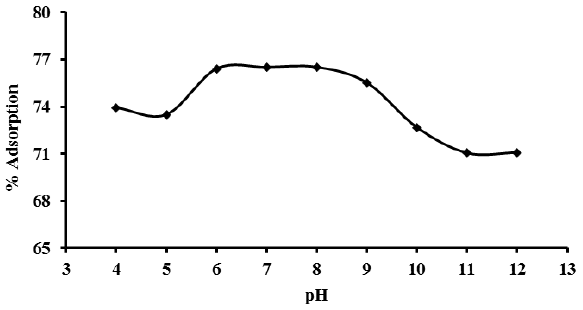
Figure 4: Effect of pH on the adsorption amoxicillin on the Ni-Al-Benzoate.